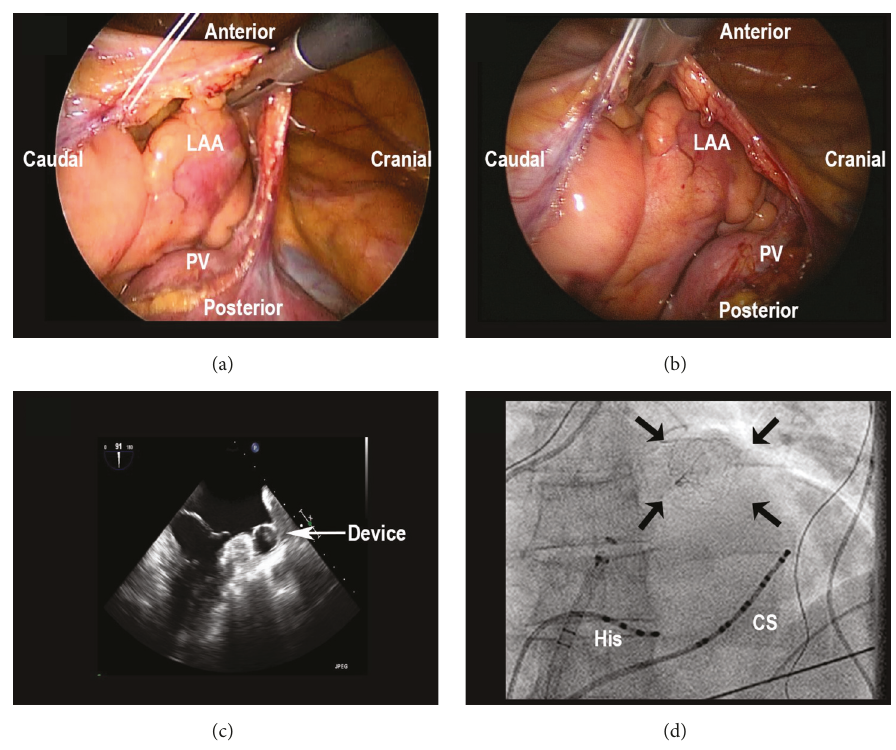
Figure 1: Watchman device implantation - Intraoperative images . (a) Left-sided thoracoscopic view of the left atrial appendage (LAA) before implantation. PV = Pulmonary vein. (b) Left-sided thoracoscopic view of the LAA after implantation, showing that implantation of the device does not lead to significant morphological changes of the LAA. (c) Per-procedural echocardiographic view after implantation. (d) Per-procedural thoracic radiographic image after implantation. His = His Bundle catheter, CS = Coronary Sinus